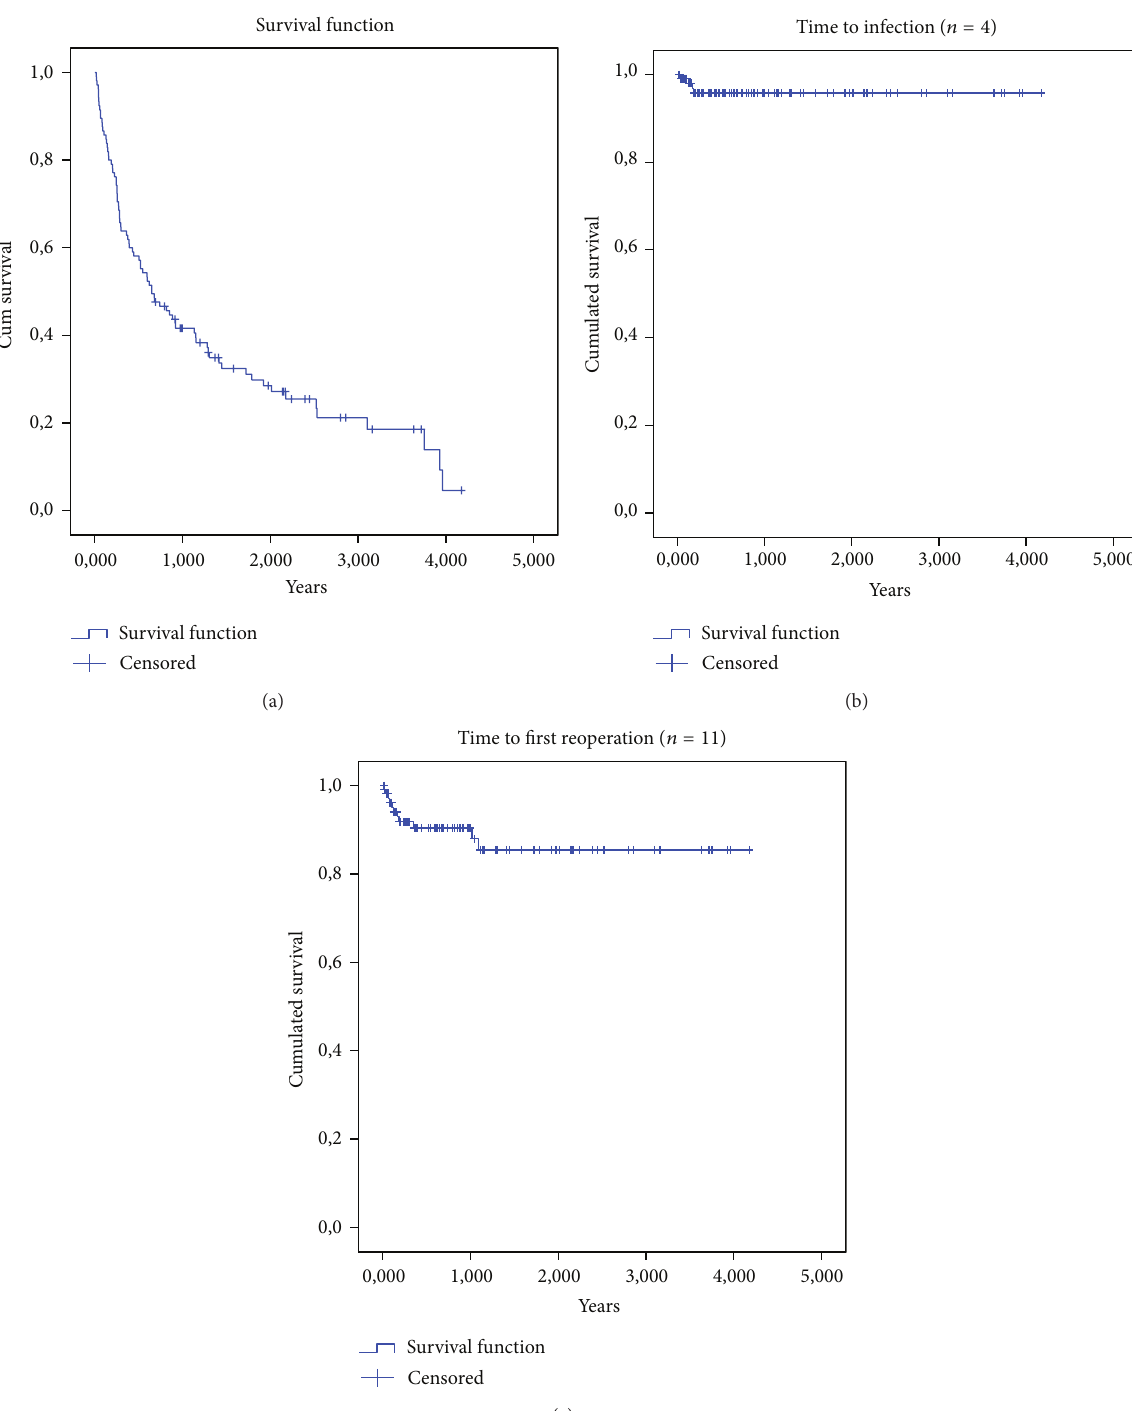
Figure 2: Kaplan Meier survival analysis showing cumulative survival rate (a), cumulative infection free survival rate (b), and cumulative reoperation free survival rate (c) for all patients ( 𝑛 = 105 ), who underwent endoprosthetic reconstruction of the hip for metastatic bone disease between 2010 and